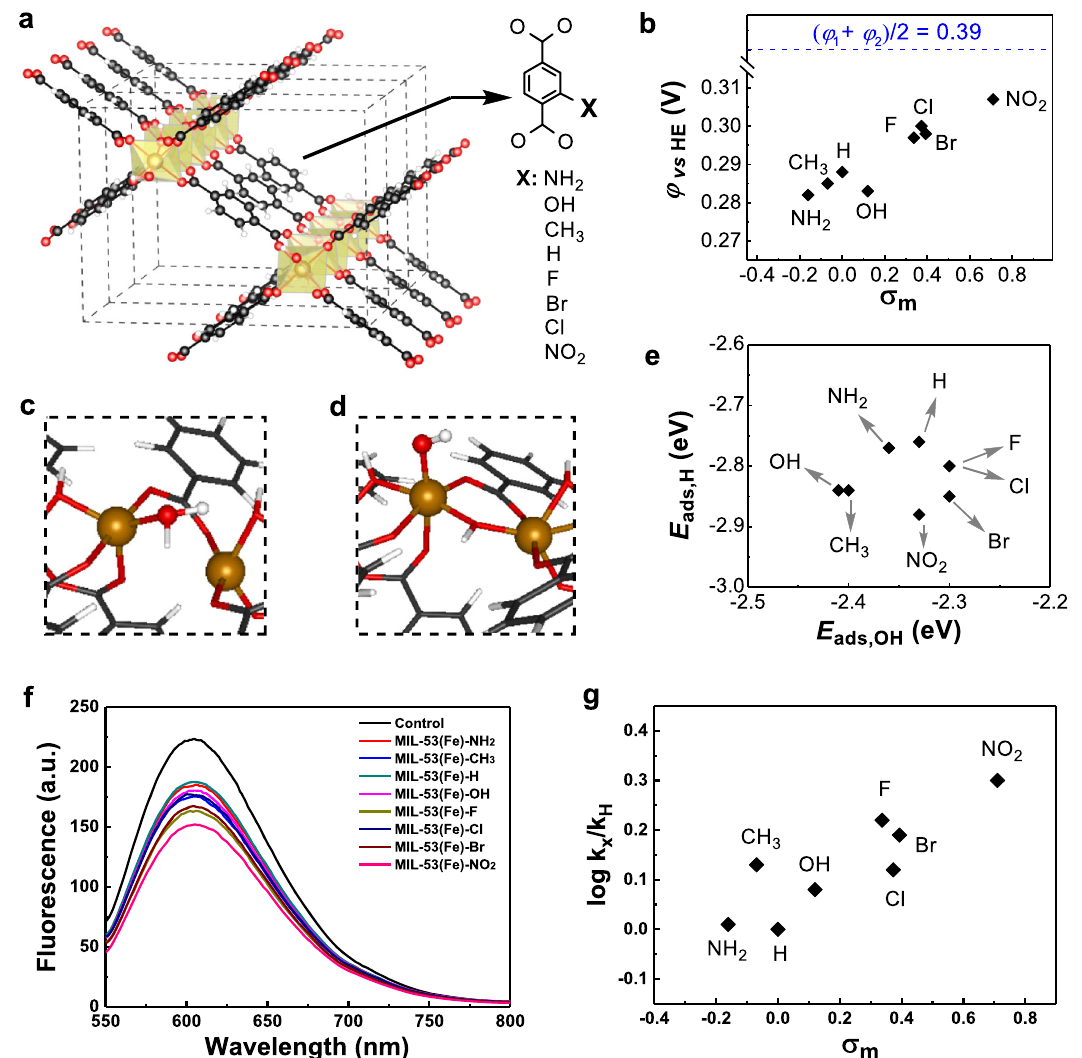
Fig. 4 Experimental veri fi cation of the screening principles. a Structural diagram of MIL-53(Fe)-X. b Reduction potentials experimentally determined for MIL-53(Fe)-X with respect to the potential of hydrogen electrode (HE) at pH = 7. c Partial structure of MIL-53(Fe)-H with an H adsorbate. d Partial structure of MIL-53(Fe)-H with a HO adsorbate. e E ads,H plotted as a function of E ads,HO for MIL-53(Fe)-X. f Fluorescent spectra for monitoring the superoxide dismutase-like activities of MIL-53(Fe)-X. g Superoxide dismutase-like activities of MIL-53(Fe)-X plotted as a function of Hammett σ m values. In a , c , and d , atoms C, O, Fe, and H are shown in black, red, brown, and white,